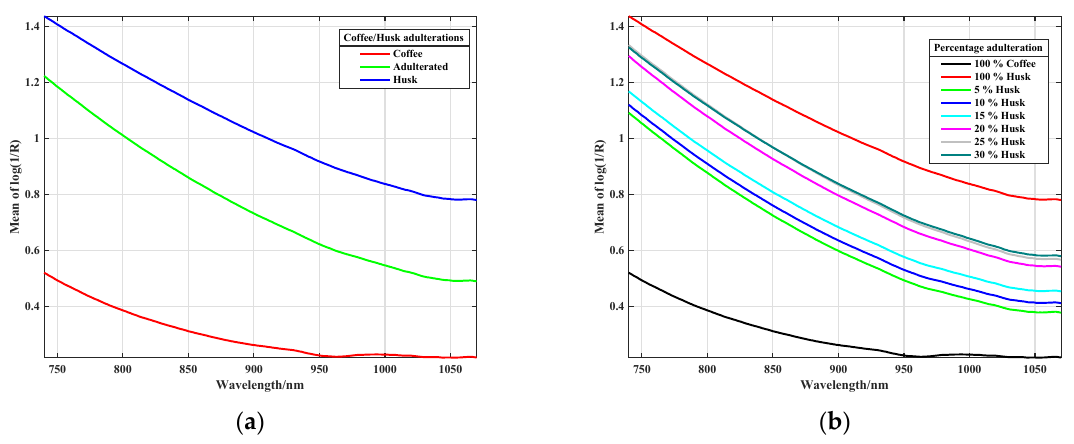
Figure 2. Mean coffee category spectral profiles in their raw form ( a ) and adulterated levels ( b ).